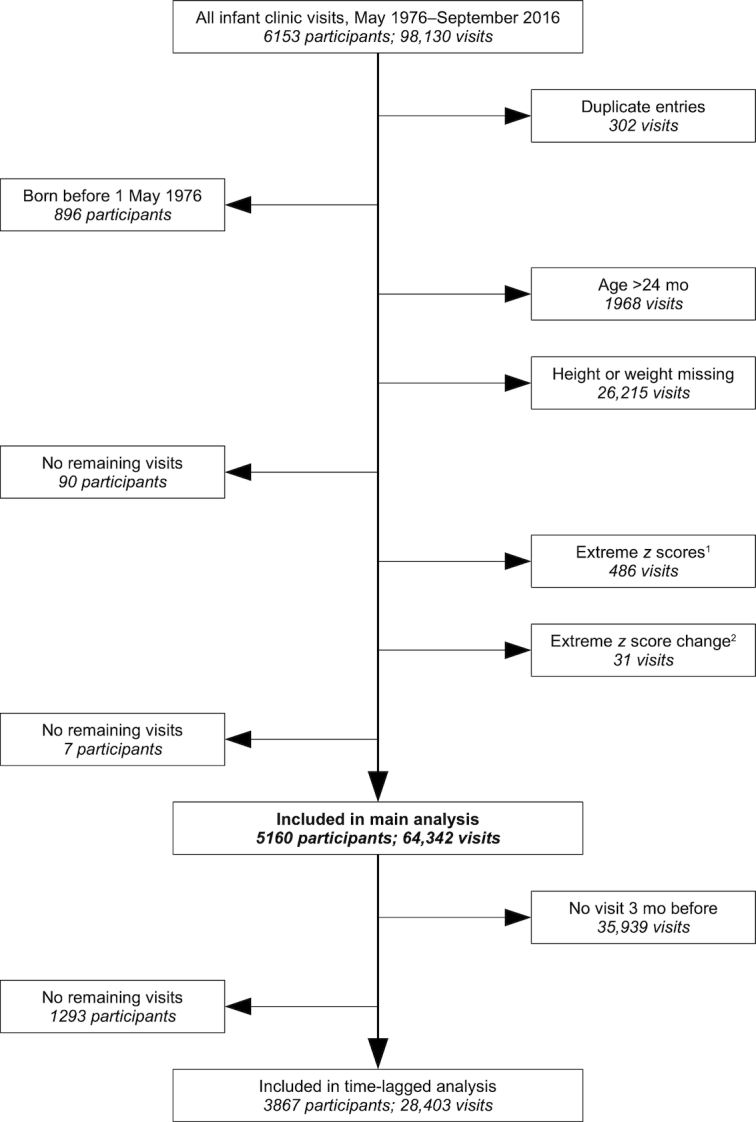
Flow diagram of sample selection from data collected at scheduled infant welfare visits at the MRC Keneba clinic. A distinction is made between excluded participants (left) and excluded visits (right); when the criteria on the right led to exclusion of all of a participant's visits, that participant was excluded because he/she had no remaining visits to include. MRC, Medical Research Center.
1Extreme z scores excluded as per WHO criteria (see Statistical methods).
2Extreme z score change of >3 SDs between consecutive visits, outlying observation excluded.